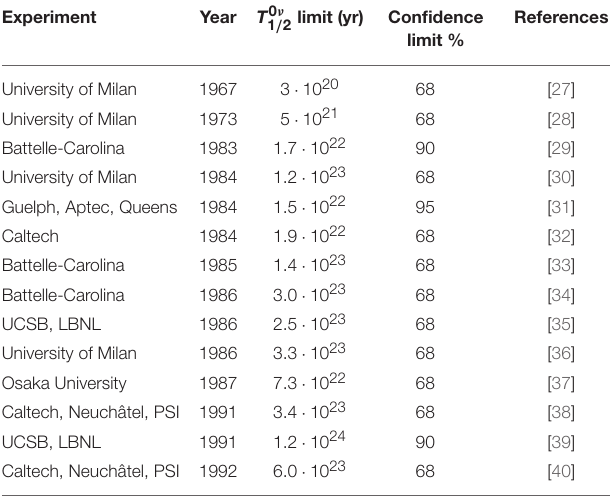
TABLE 1 | Results of 76 Ge 0 νββ experiments using natural abundance Ge.